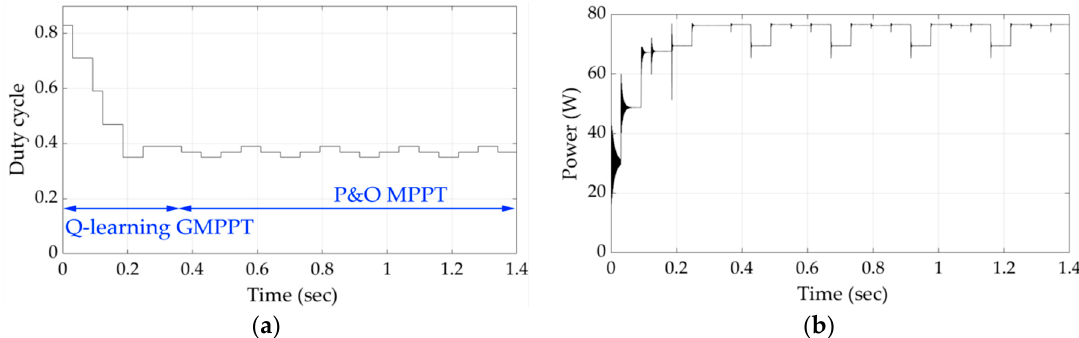
Figure 15. Results during execution of the proposed Q-learning-based GMPPT process for shading pattern 8: ( a ) duty cycle versus time and ( b ) PV array output power versus time.